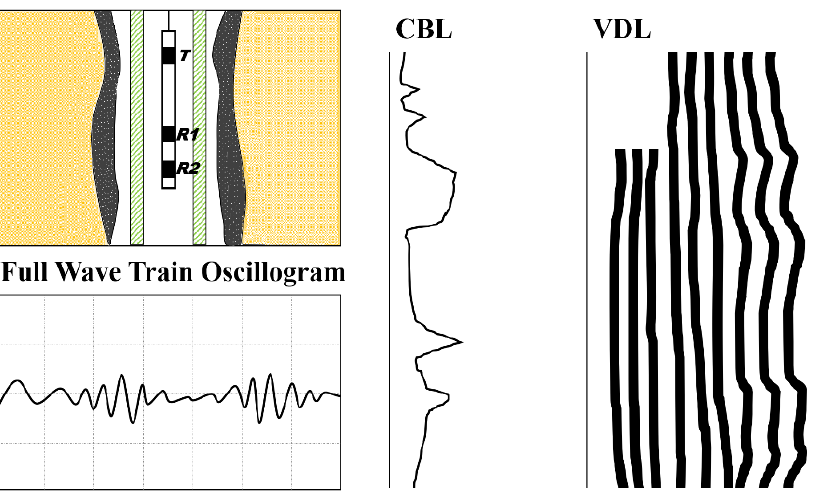
Figure 6. Waveform and CBL-VDL of poor cementation at the first interface and good cementation at the second